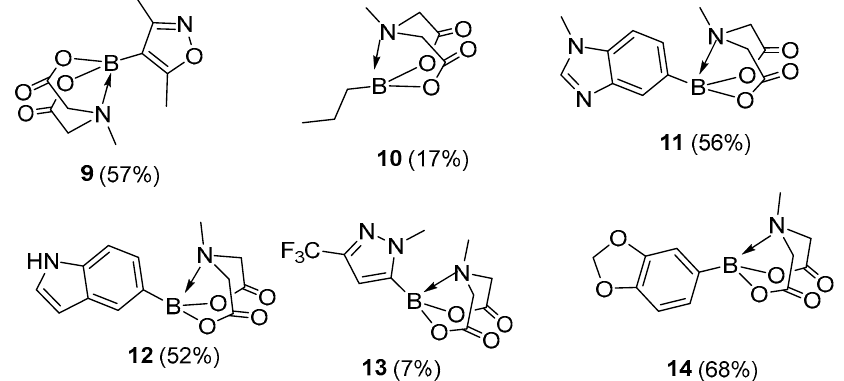
Figure 3. Other MIDA Boronates Synthesised in DMF.